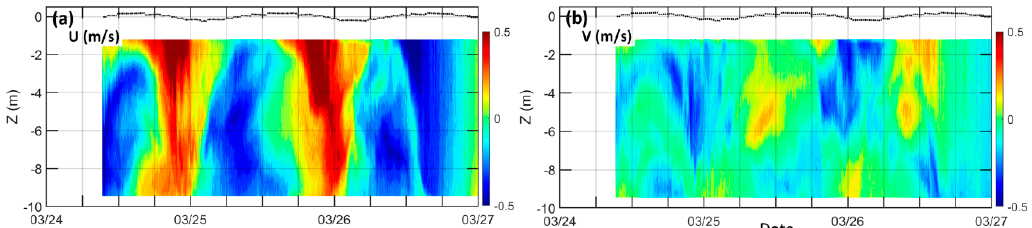
Figure 11. Time series of ADCP currents from mooring BP2. ( a ) U component (flow toward the east positive); ( b ) V component (flow toward the north positive). Times indicated are local (UTC—5 h).